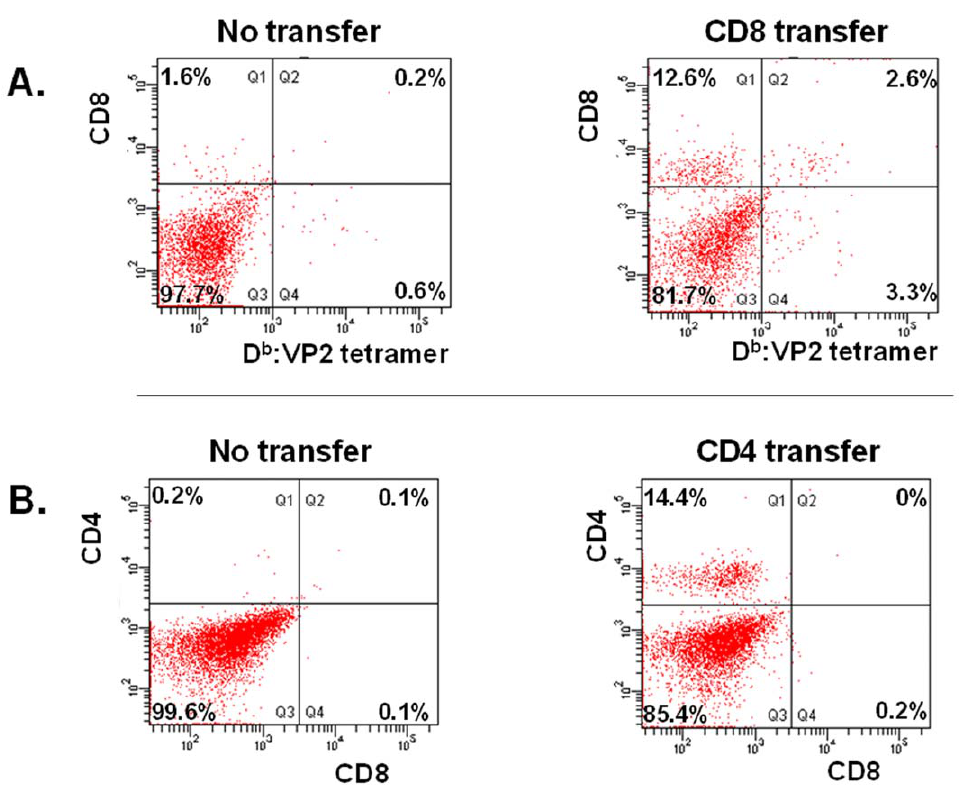
Figure 3. FACS analysis of brain infiltrating immune cells on day 7 following TMEV infection. Figure 3A (top half) shows transfer efficiency following adoptive transfer of CD8 + splenocytes from C57BL/6 donors into RAG-1 deficient hosts. Note that with sham transfer, only 1.6% of BIL-s is CD8 + and only 0.2% recognizes VP2 epitopes, whereas transfer of CD8 + cells results in 12.6% CD8 + positivity and 2.6% positivity for VP2 peptide. The 3.3% VP2 + CD8 2 cells are overall unidentified, and potentially represent dead cells that bind tetramer, auto fluorescing CNS cells, dying CD8 + tetramer + cells that have become CD8 2 tetramer + , or NK cells with receptors specific for class I. Figure 3B (lower half) describes transfer efficiency in our CD4 transfer experiments. With sham transfer, only 0.2% of BIL-s is CD4 + , whereas with CD4 transfer, 14.4% positivity is demonstrated.